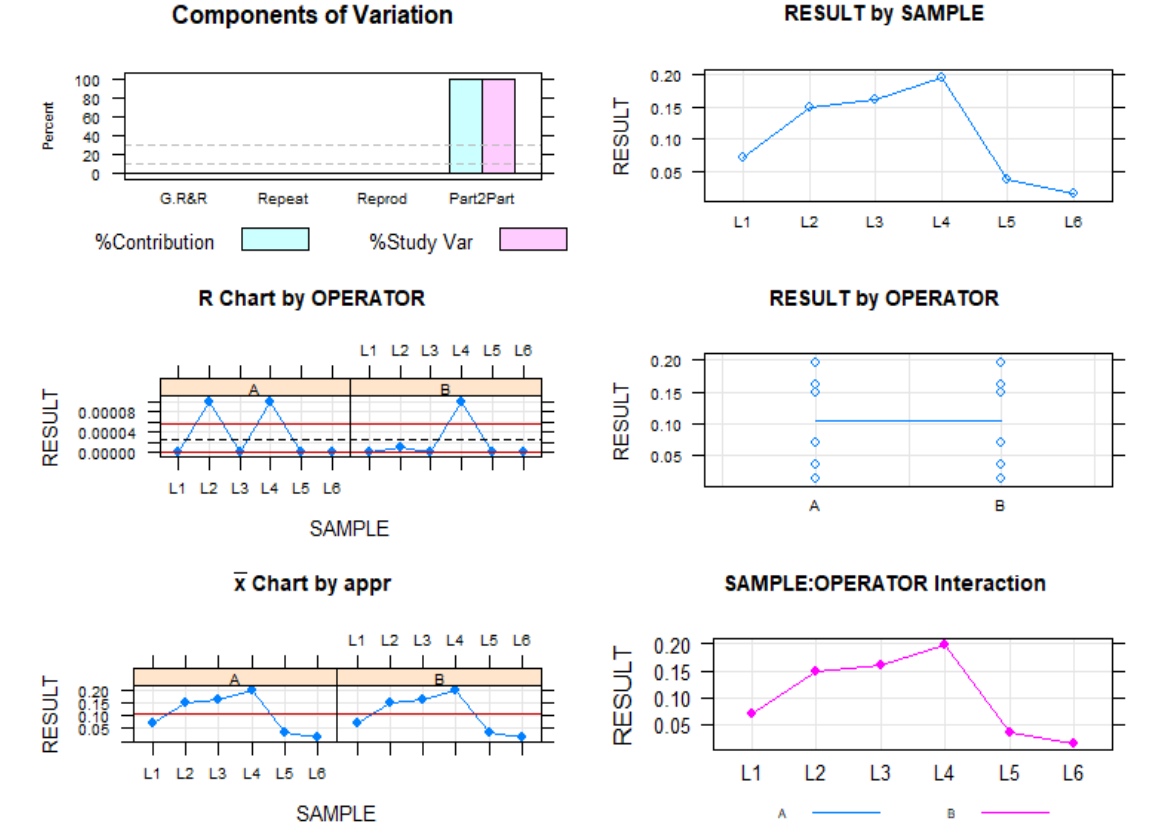
Figure 6. Measurement evaluation chart of the measurements of the volume wear of CM-wire NiTi alloy endodontic reciprocating files after use indicating the difference between the measurements of each observer to evaluate the impact of each variable on the total variation obtained (components of variation) with a mean control chart and a range control chart (R chart by operator and x chart by appr), graphed measurement points (result by sample and result by operator), and interactions (sample–operator interaction). The values are within the confidence limits.